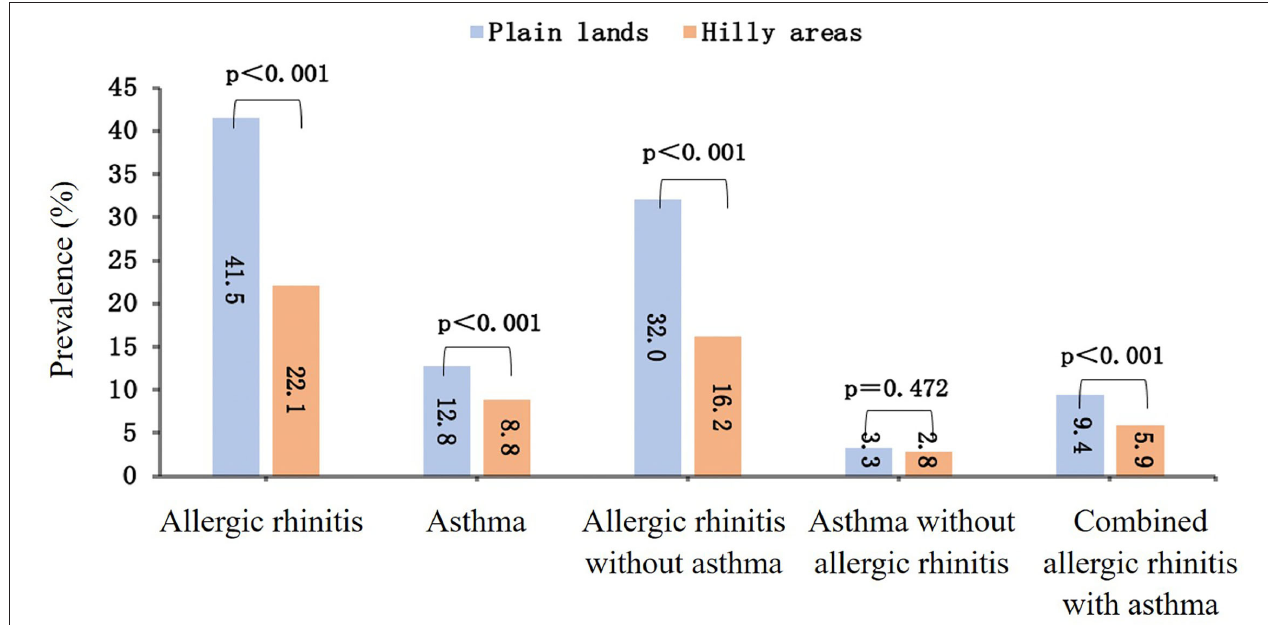
FIGURE 2 | The prevalence of allergic rhinitis, asthma, allergic rhinitis without asthma, asthma without allergic rhinitis, and combined allergic rhinitis with asthma in plain lands and hilly